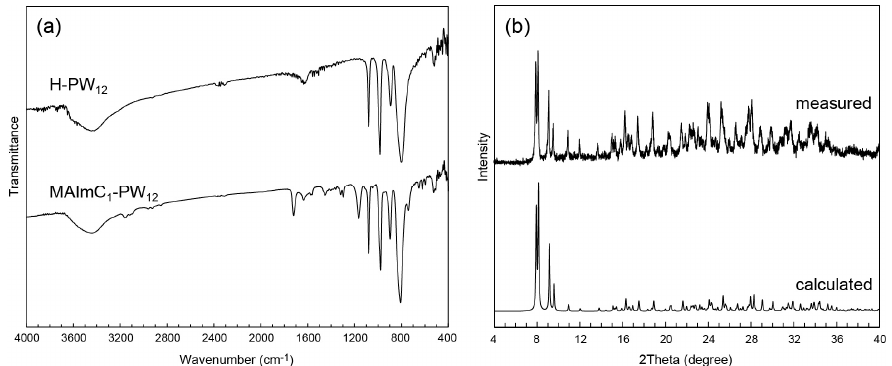
Figure 2. ( a ) IR spectra of H-PW 12 (upper) and MAImC 1 -PW 12 hybrid monomers (bottom); and ( b ) powder X-ray diffraction patterns of the MAImC 1 -PW 12 hybrid monomer measured under ambient atmosphere (upper) and calculated by using the structure obtained by single-crystal X-ray diffraction (bottom).